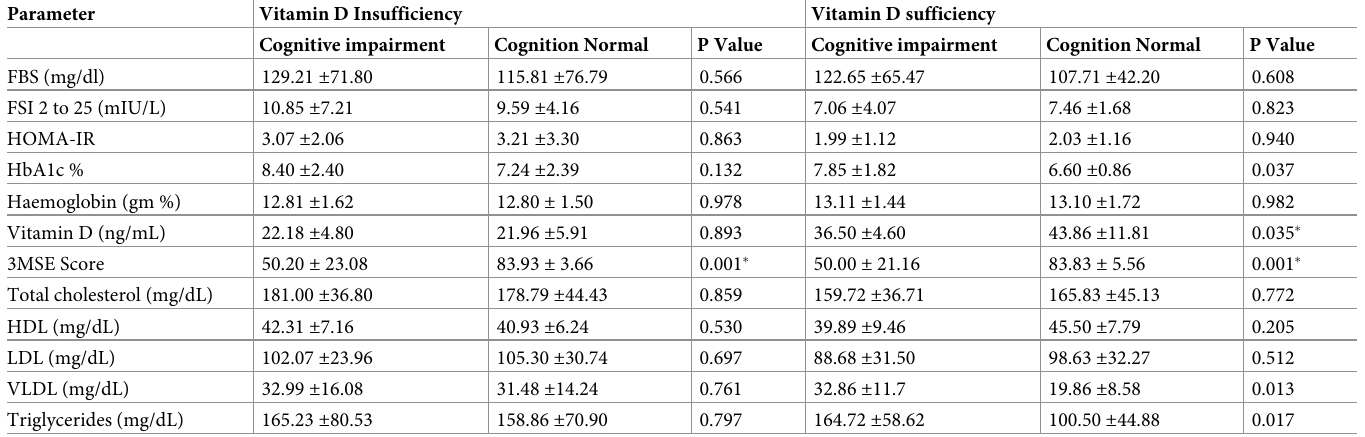
Table 2. Comparison of various parameters among diabetic subjects with vitamin D insufficiency and cognitive impairment. Parameter Vitamin D